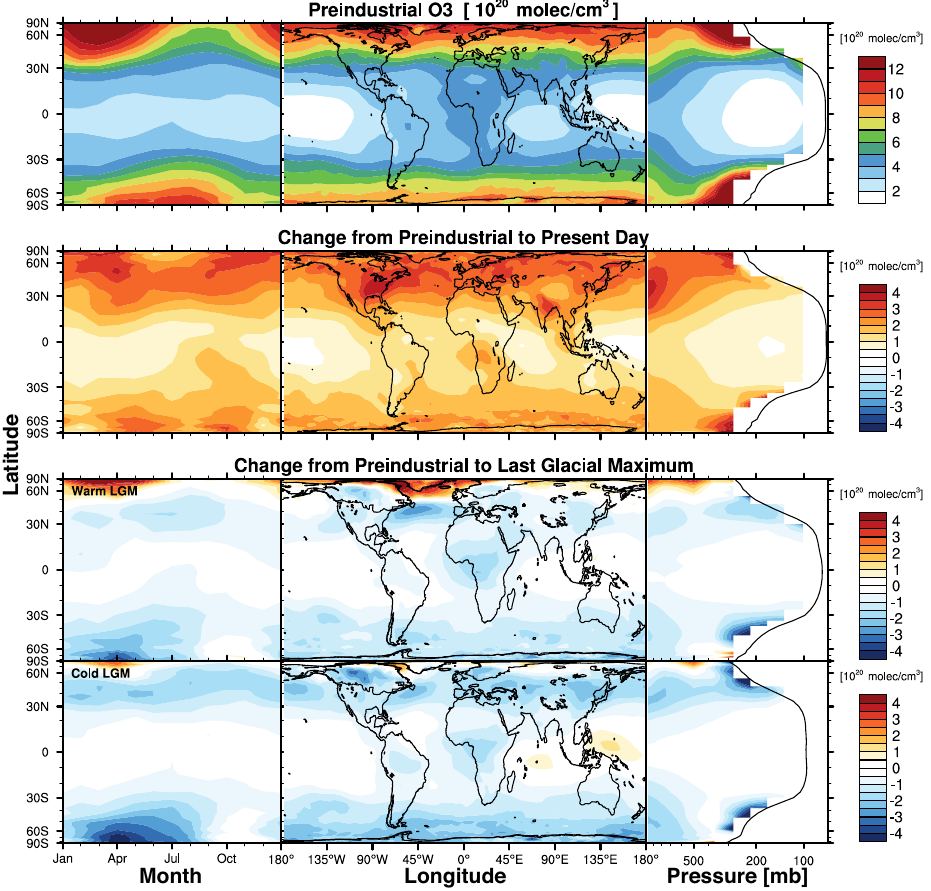
Fig. 14. Same as Fig. 12, but for tropospheric ozone concentrations ( 10 20 molec cm (cid:0) 3 ).